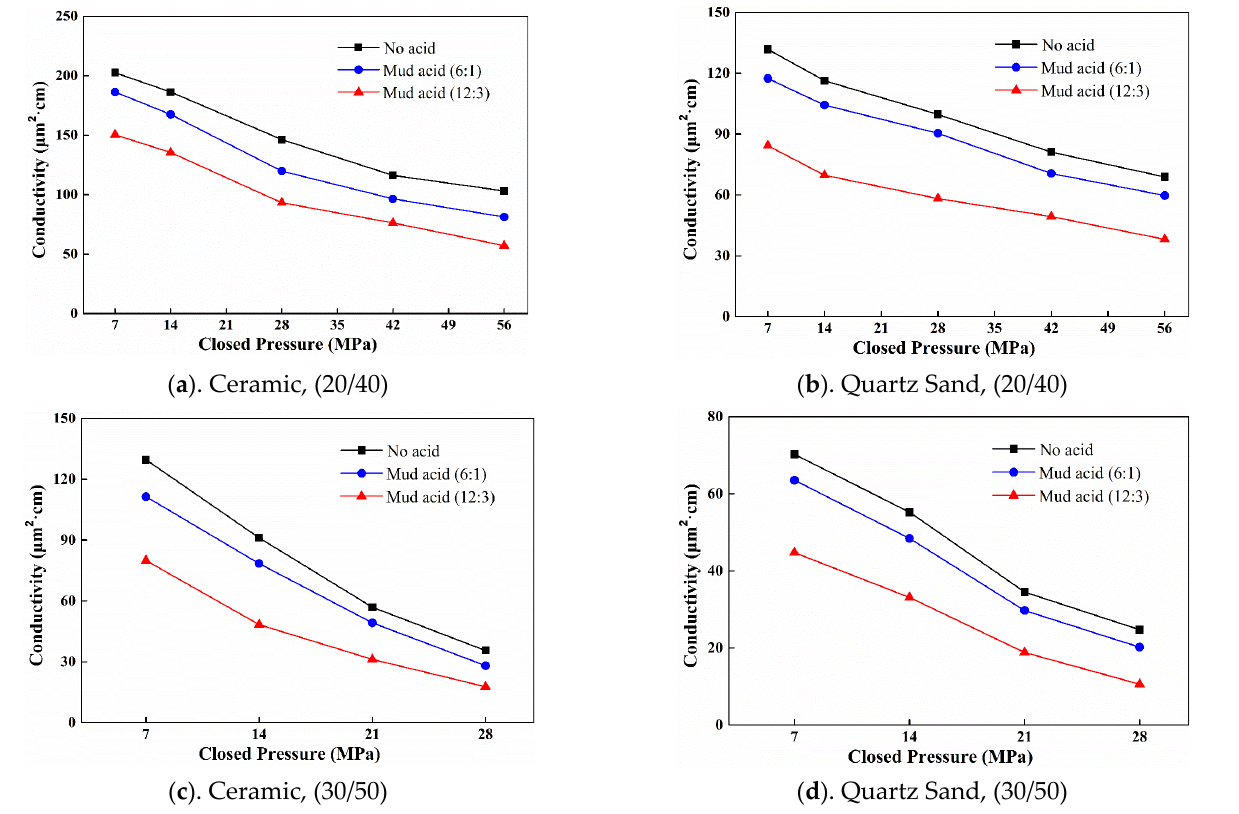
Figure 4. ( a – d ) The conductivity of ceramic and quartz sand of different sizes under different closure pressures after mud acid soaking.